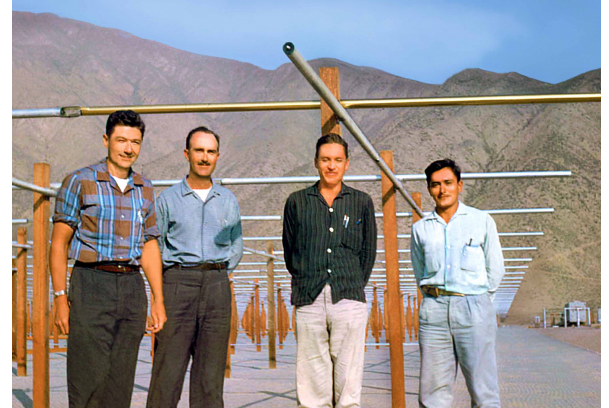
Figure 7. An example of the first electron density profile mea- surements conducted with one-eighth of the Jicamarca antenna ar- ray and a modified Collins transmitter operating at 50MHz in April 1961 (adapted from Bowles, 1961a).